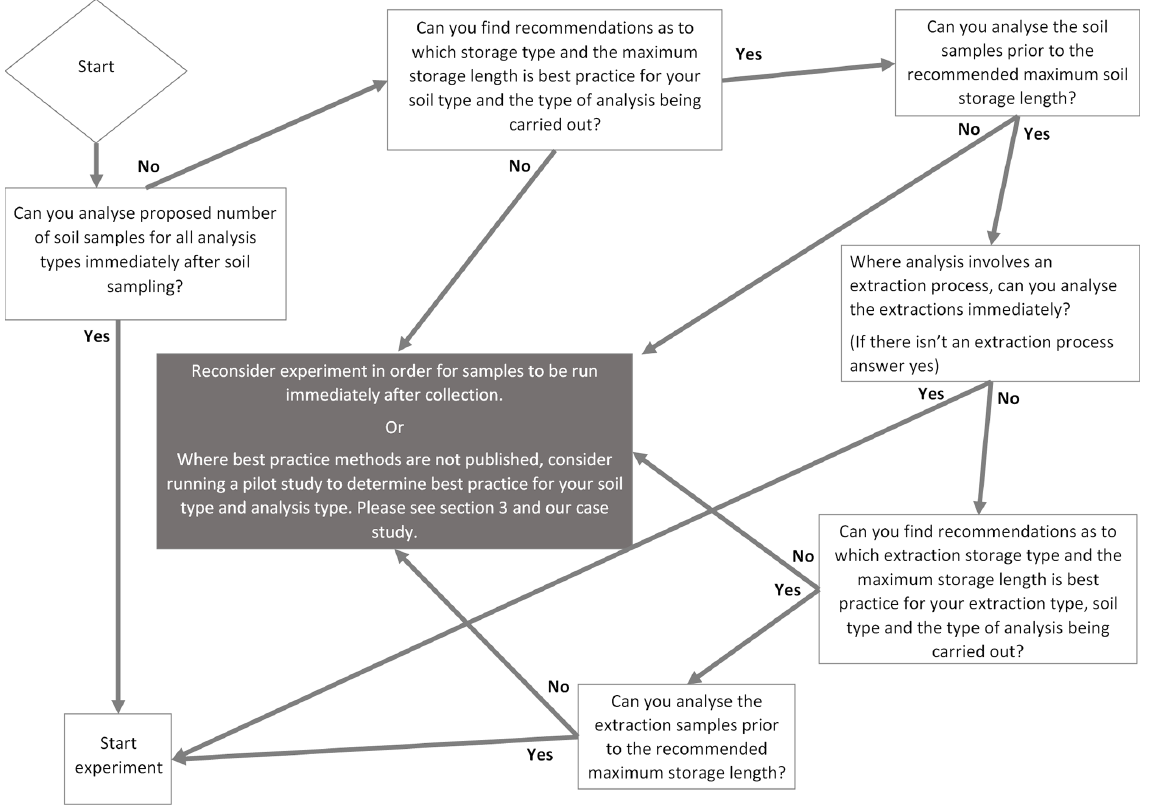
Figure 1. Schematic flow chart depicting necessary steps to determine best storage practices for soil and soil extracts in ecological studies.